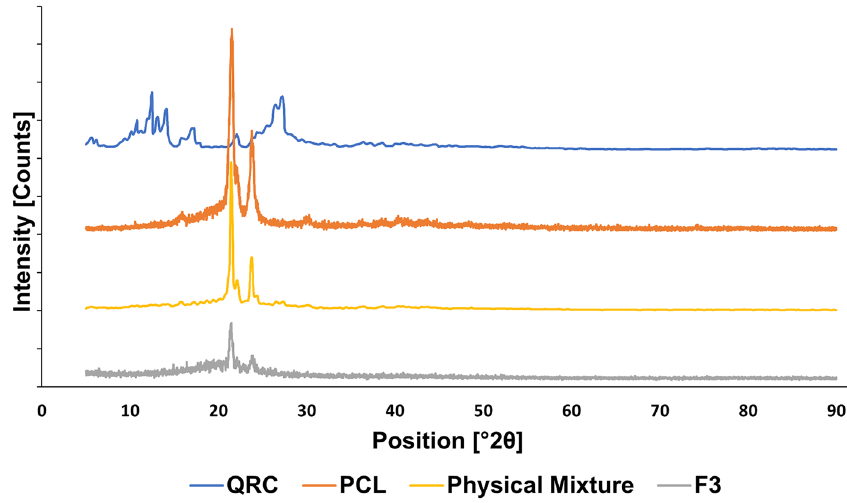
Figure 4. XRD charts of QRC, PCL, physical mixture, and F3.